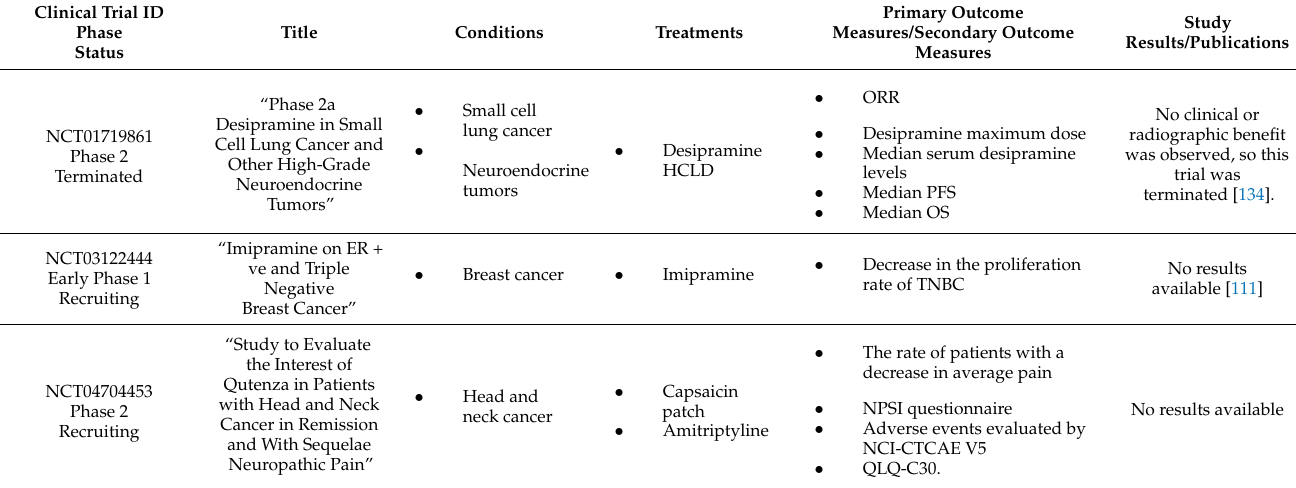
Table 3. Clinical trials evaluating antitumoral effects of